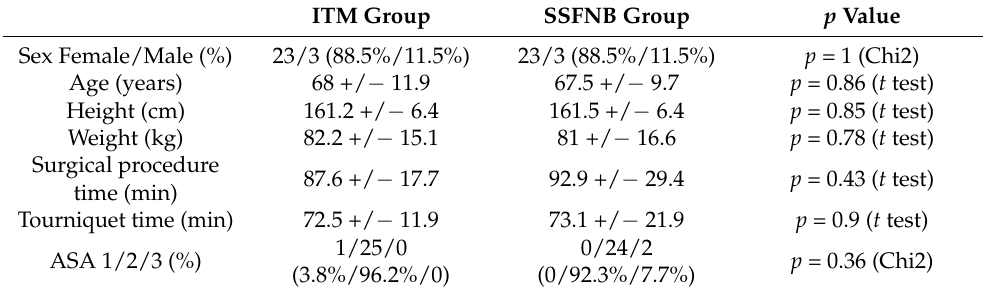
Table 1. Patient